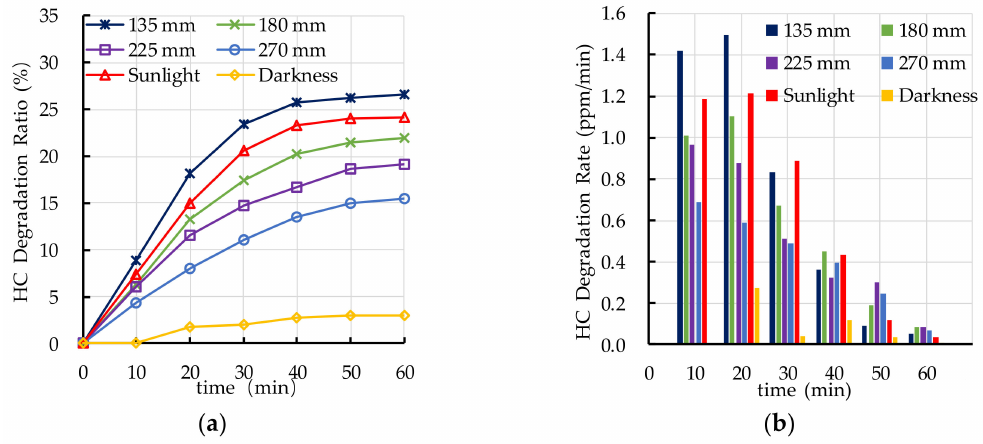
Figure 8. E ff ect of light source on photocatalytic degradation of HC: ( a ) HC degradation ratio; ( b ) HC degradation